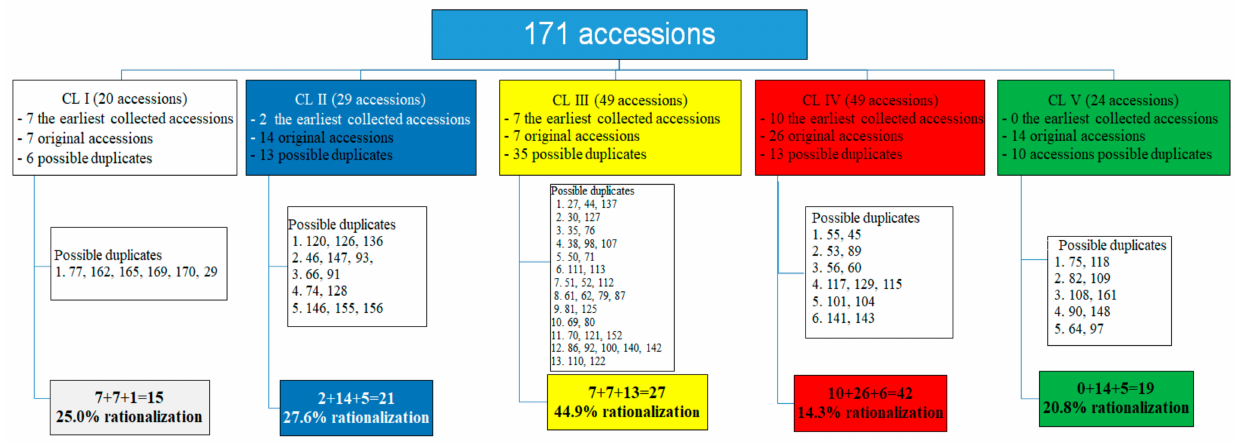
Figure 2. Possible duplicate accessions in the MRIZPGB white Montenegrin maize gene pool.